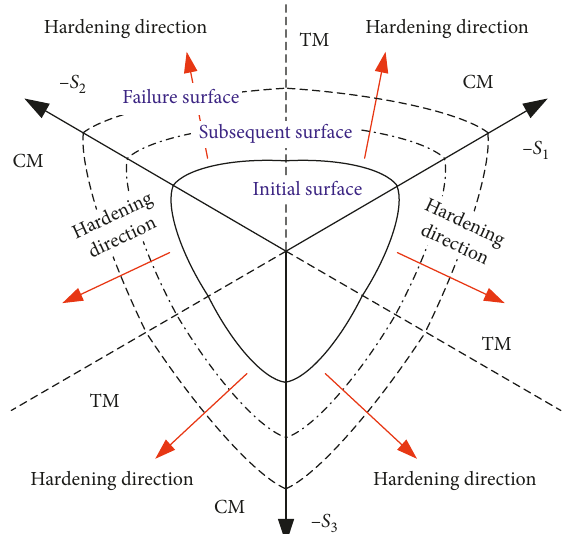
Figure 19: Isotropic hardening in deviatoric plane